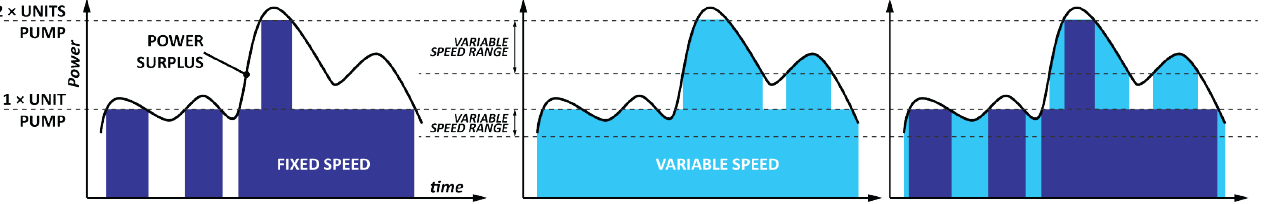
Figure 3. Power surplus utilisation with multiple units in pump mode (example with two units): Fixed-Speed units ( left ), Variable-Speed units ( center ), comparison ( right ).